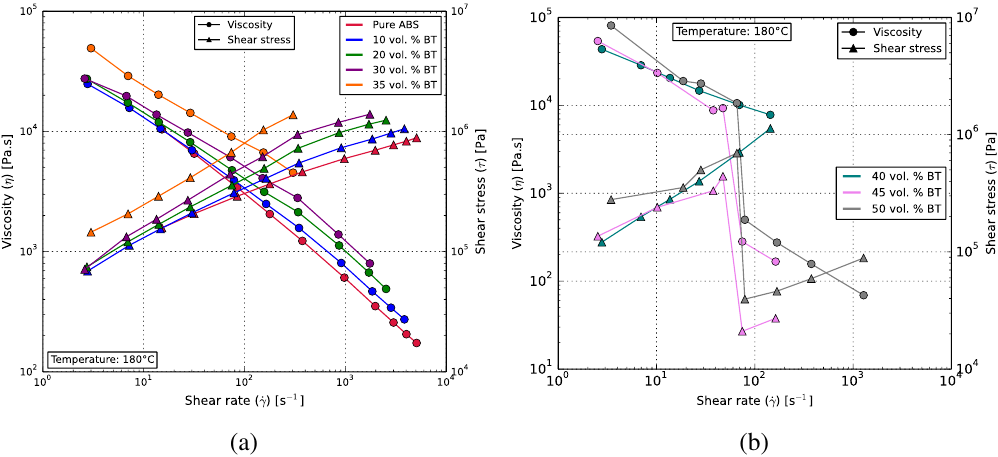
Figure 7. ( a ) Results obtained from the rheological analysis of the ABS-BT composites. The viscosity can be seen to decrease with increasing shear rate, indicating shear thinning behavior. The viscosity at any given shear rate is higher for samples with higher BT content. ( b ) The rheological behavior of composites with BT loadings of 40, 45 and 50 vol %. These could not be 3D printed. A stick-slip-like behavior can be seen for the 45 and 50 vol %